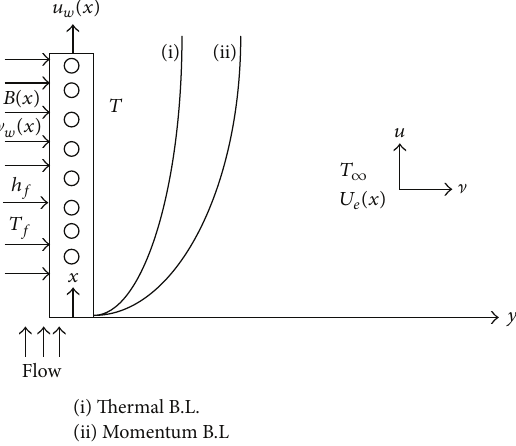
Figure 1: Flow configuration and coordinate